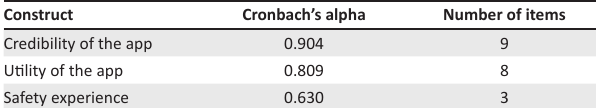
TABLE 4: Cronbach’s alpha for the three constructs.